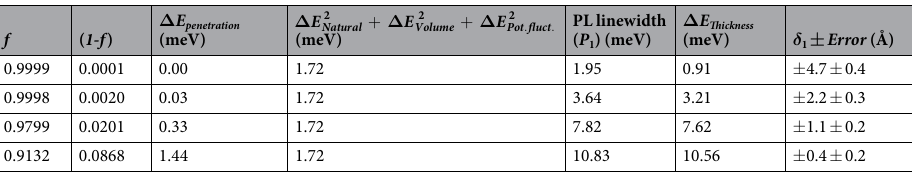
Table 3. Probability of finding excitons inside the barrier layer ( 1 - f ) is computed by solving Schrödinger equation in FDM as shown in Fig. 4. Spectral broadening due to wave function penetration is estimated and thereafter PL linewidth broadening due to the thickness fluctuation are estimated from equation 1. Summary of δ 1 estimated for all the QWs are